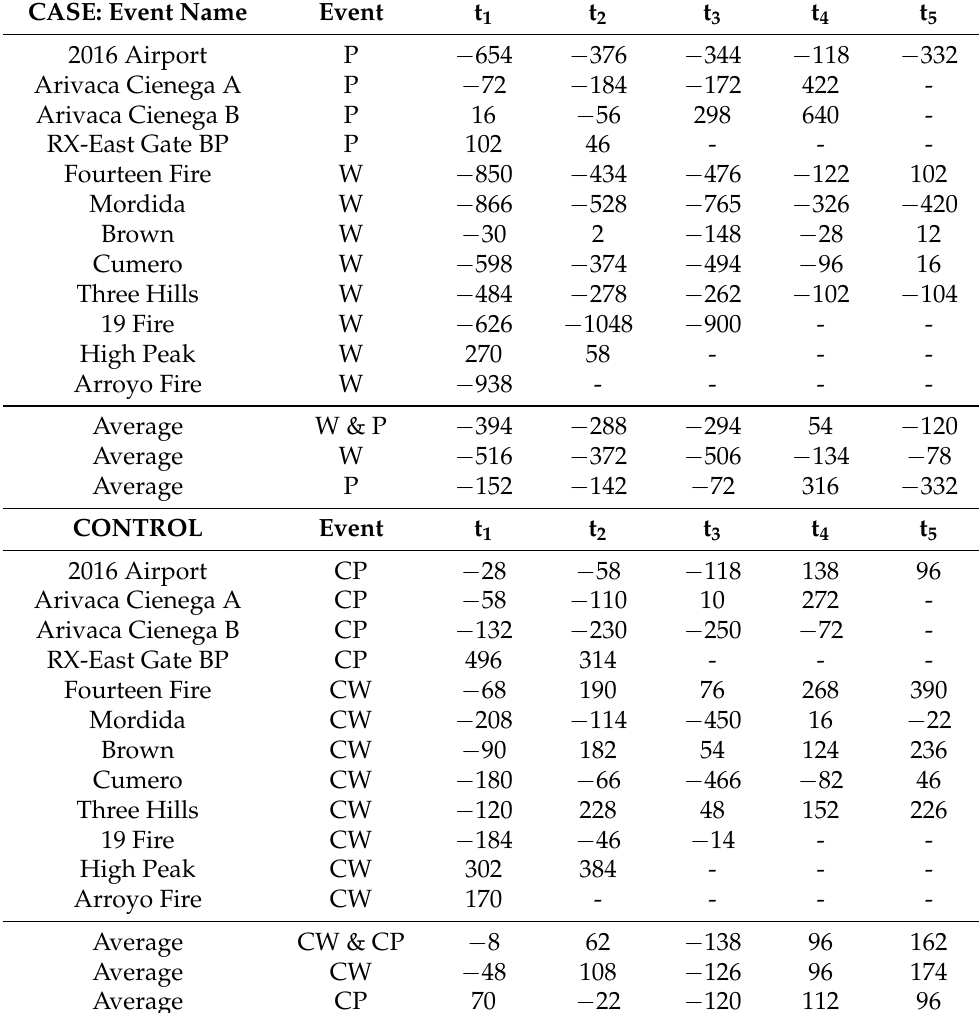
Table A4. Annual changes in estimates of fine-fuels (kg/ha) since time (t) of ignition for prescribed fire (P) and wildfire (W) relative to control (C) areas from 2015 to 2020 at